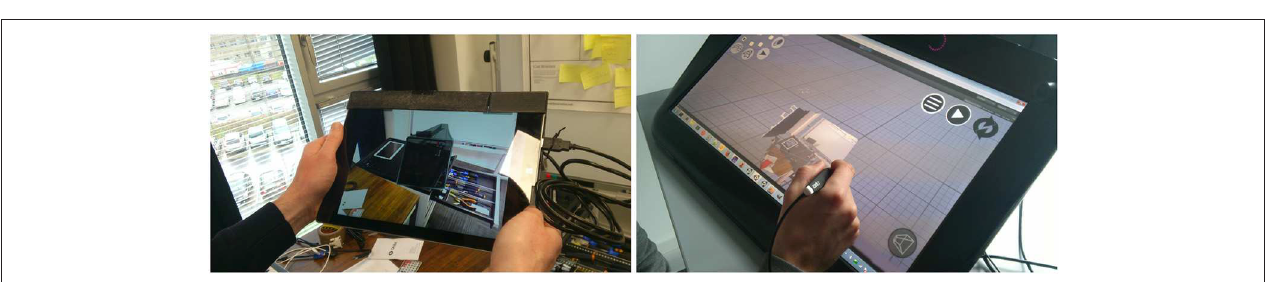
FIGURE 12 | Illustration of the asymmetrical (HWD and WIM) prototype. The agent on the left is guided by the remote expert on the right.